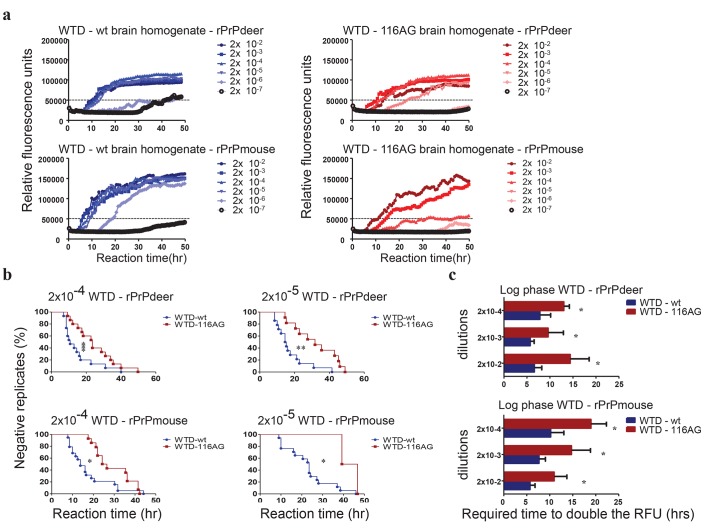
RT-QuIC analysis of WTD prion seeding and amplification characteristics using deer and mouse rPrP substrates.(a) The curves depict a representative RT-QuIC response of serially diluted (2x10-2 to 2x10-7) wt (left panels) and 116AG (right panels) brain homogenates using rPrP deer or mouse substrate. Fluorescence signals were measured every 15 min. The x-axis represents the reaction time (hours) and the y-axis represents the relative fluorescence units (RFUs), and each curve represents a different dilution. Mean values of four replicates were used for each dilution. The cut-off is indicated at app. 50,000 RFU based on the average fluorescence values of negative control +5SD. (b, c) The RT-QuIC responses of wt and 116AG were quantified by calculating different parameters: lag phase (b), and log phase (c). Mean values of 5 experiments with 4 replicates each were used and statistical analyses were evaluated using log-rank (Mantel-Cox) test for the lag phase (b) and unpaired t-test for the log phase (c). *P <0.05, **P <0.01 and ***P <0.005 refers to differences between WTD isolates (GraphPad Prism software).